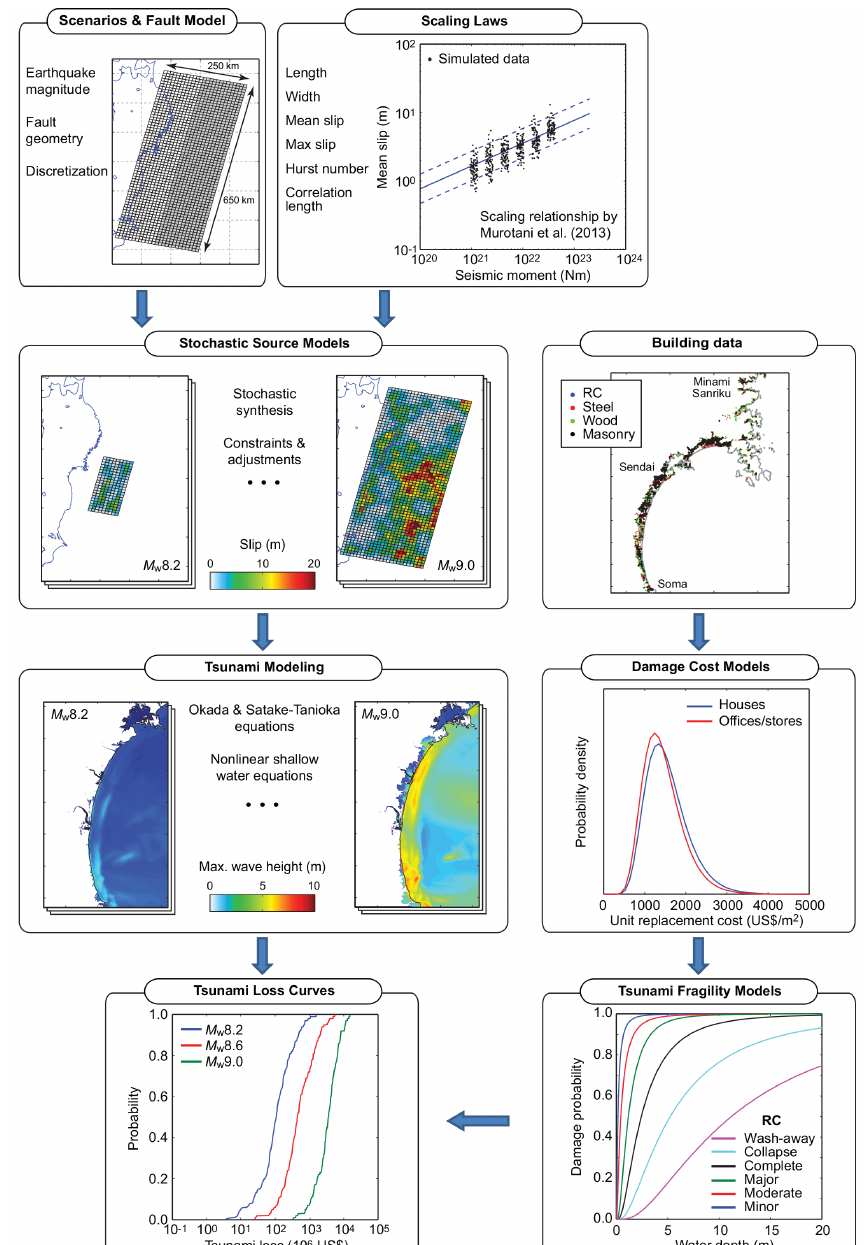
Figure 1. Probabilistic tsunami hazard and risk